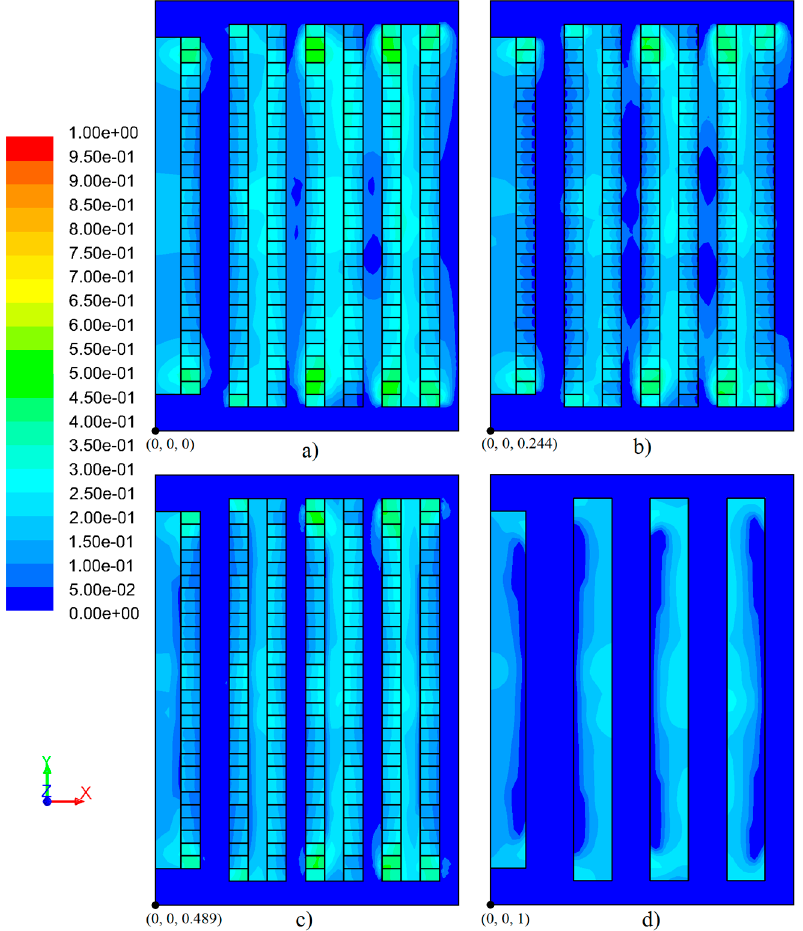
Figure 10. The results of the field of temperature in the x–y plane through the planes: ( a ) z adm = 0; ( b ) z adm = 0.244; ( c ) z adm = 0.489; and ( d ) z adm = 1. Appl. Sci. 2019 , 9 , x FOR PEER REVIEW 16 of 30